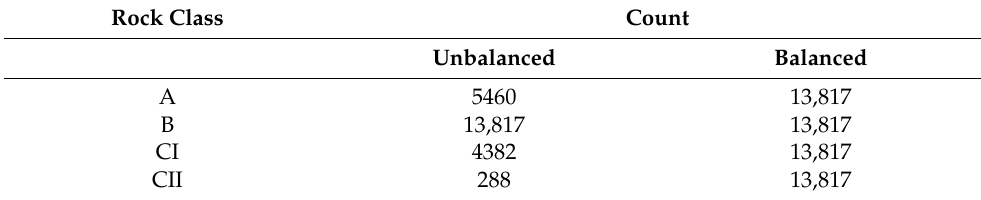
Table 5. Amount of data from each rock class before and after oversampling the minority classes.